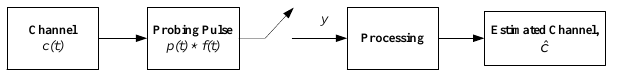
Figure 30. An equivalent block diagram of channel estimation.